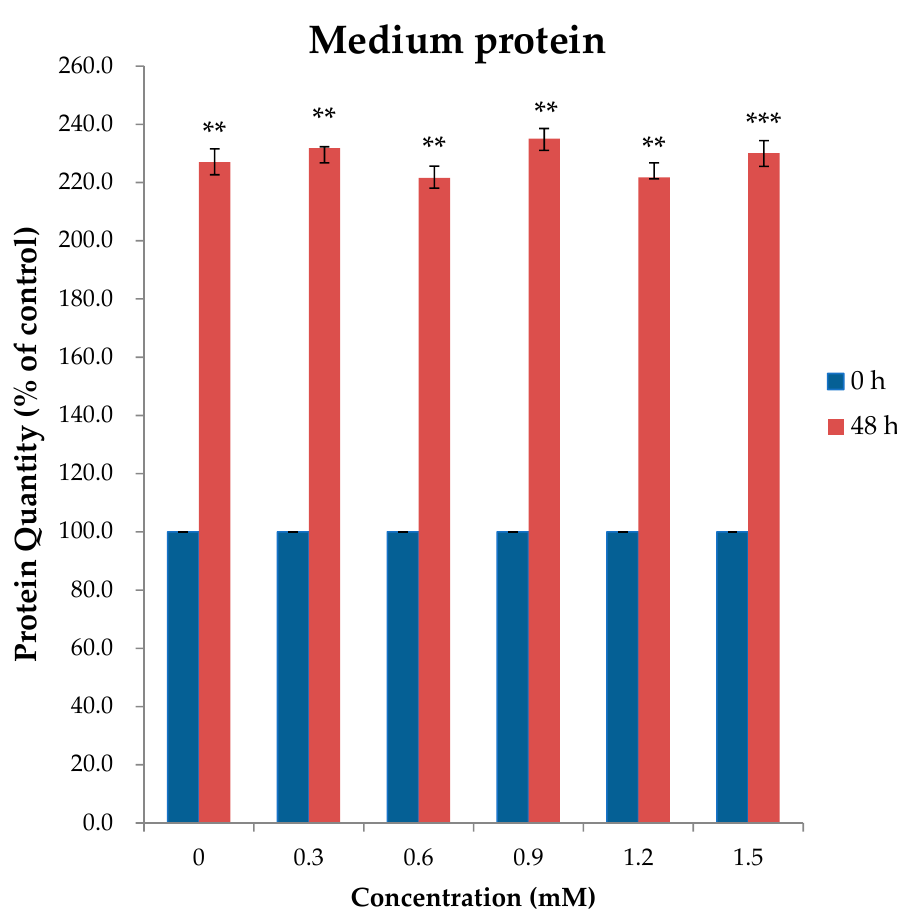
Figure 2. Relative medium protein content in MAC-T cells incubated with different levels of L-Trp (0, 0.3, 0.6, 0.9, 1.2, 1.5 mM) for 48 h. Values are expressed as means ± SE ( n = 6 per group). ** < 0.01, *** < 0.001.